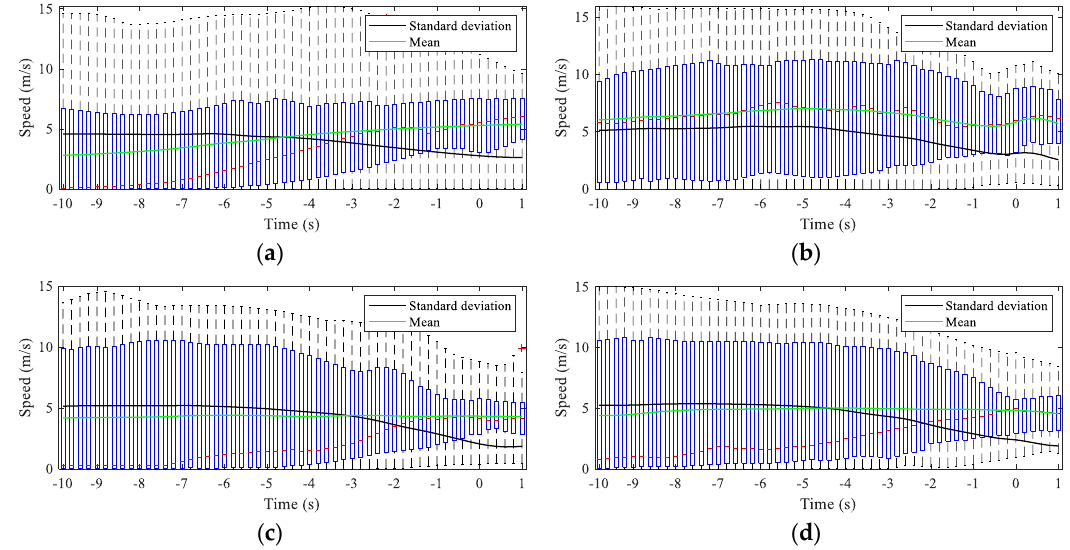
Figure 9. Boxplot of the speeds of the vehicle in the Lankershim and Peachtree datasets. ( a ) Statistics of the turn left (TL) speed in the Lankershim dataset. ( b ) Statistics of the turn right (TR) speed in the Lankershim dataset. ( c ) Statistics of the TL speed in the Pearchtree dataset. ( d ) Statistics of the TR speed in the Pearchtree dataset.